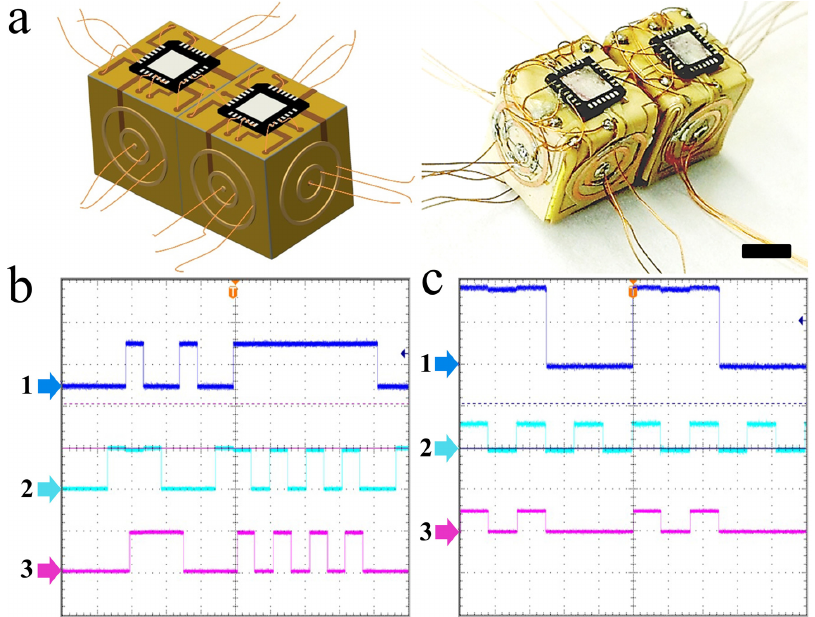
Figure 6. Verification of functionality of a monomer E-block. ( a ) Schematic and optical images of a wired E-block monomer. The scale bar indicates 5 mm; ( b , c ) experimentally recorded oscilloscope readings show the output of the monomer configured as ( b ) OR gate and ( c ) AND gate. 1 and 2 represent inputs and 3 is the output.